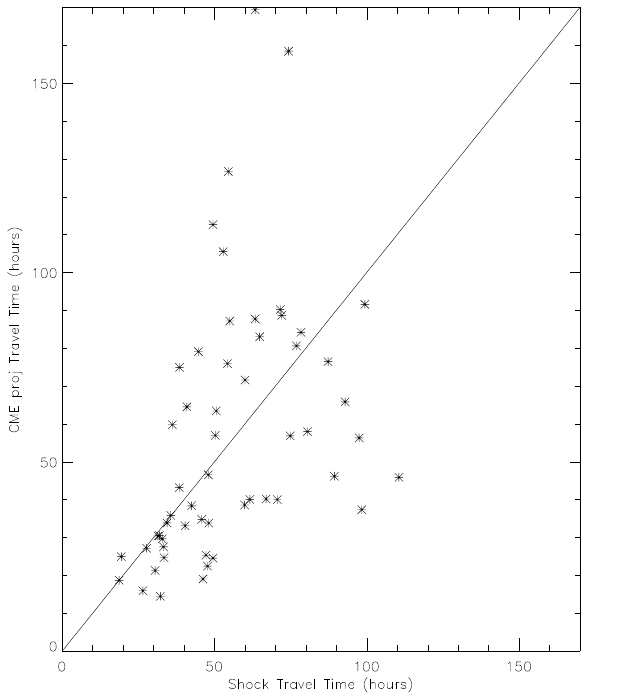
Fig. 3. Latitude versus longitude distribution of CMEs sources.